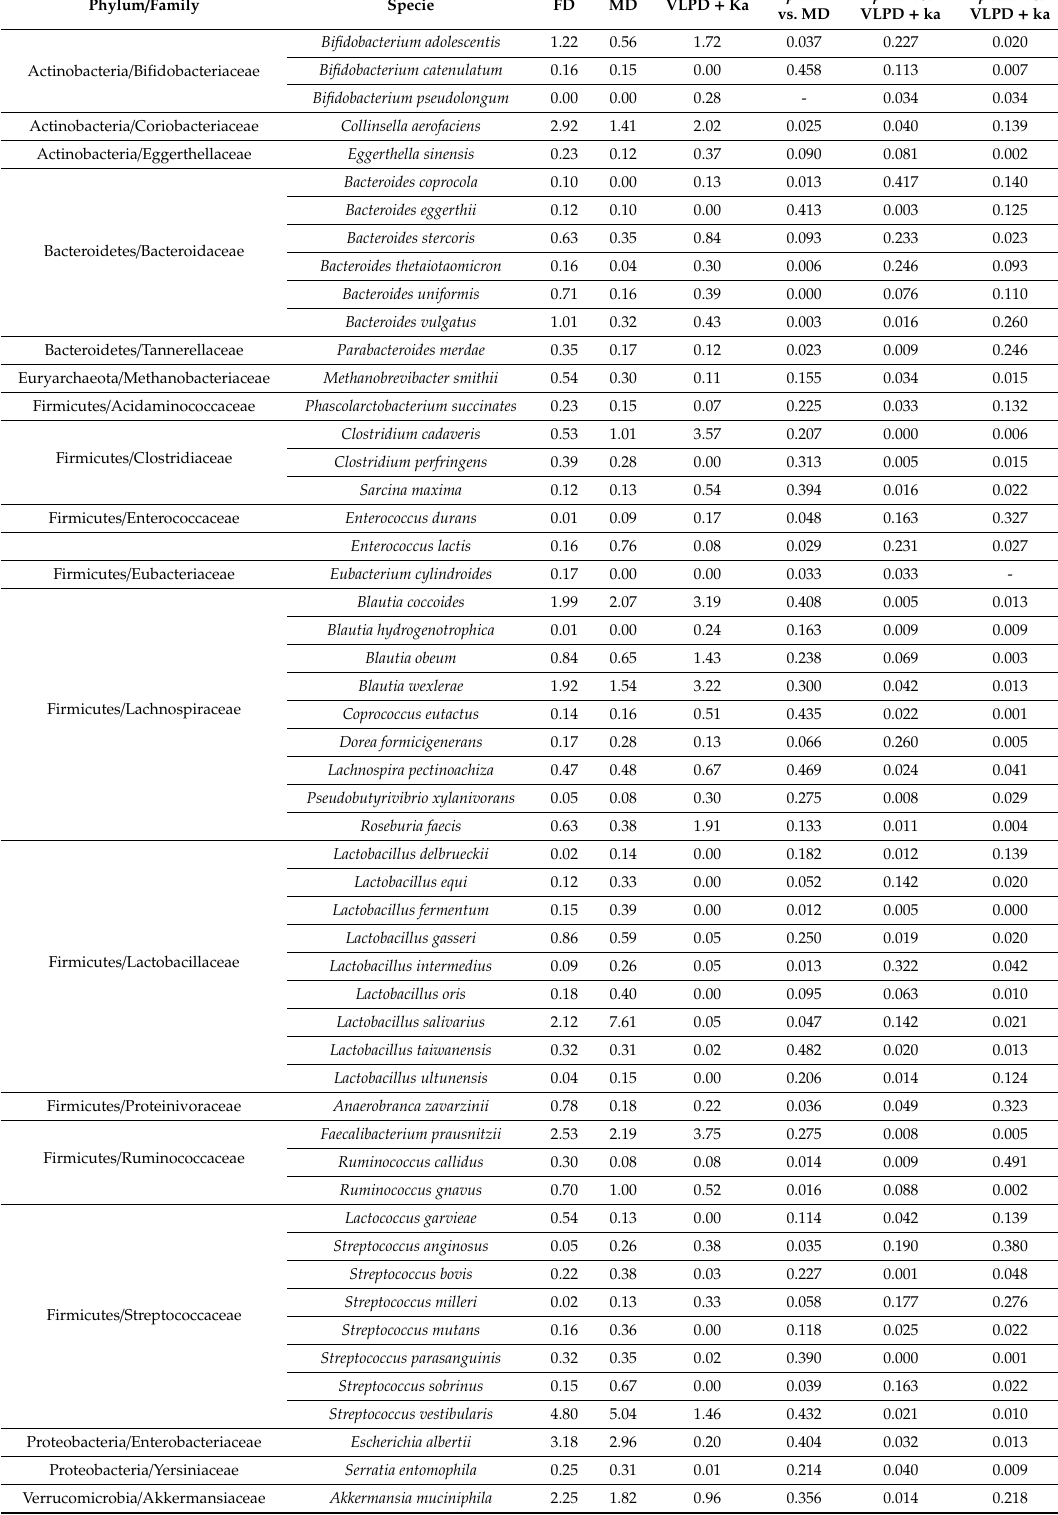
Table 3. Diet associated changes of microbiome in chronic kidney disease (CKD) patients. Average of relative abundance (%) of bacterial species di ff erently found ( p < 0.05) in feces of CKD patients after free diet (FD), Mediterranean diet (MD), and very low protein diet plus essential amino acids and ketoanalogs (ALFA-KAPPA) (VLPD +